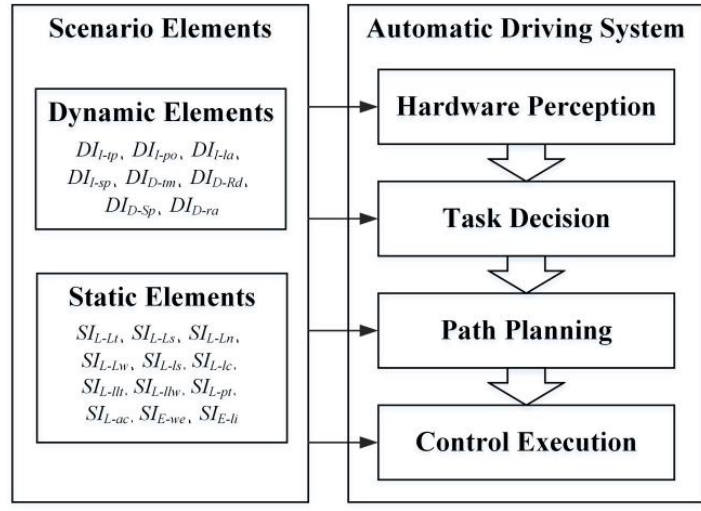
Figure 4. The content of ETM.